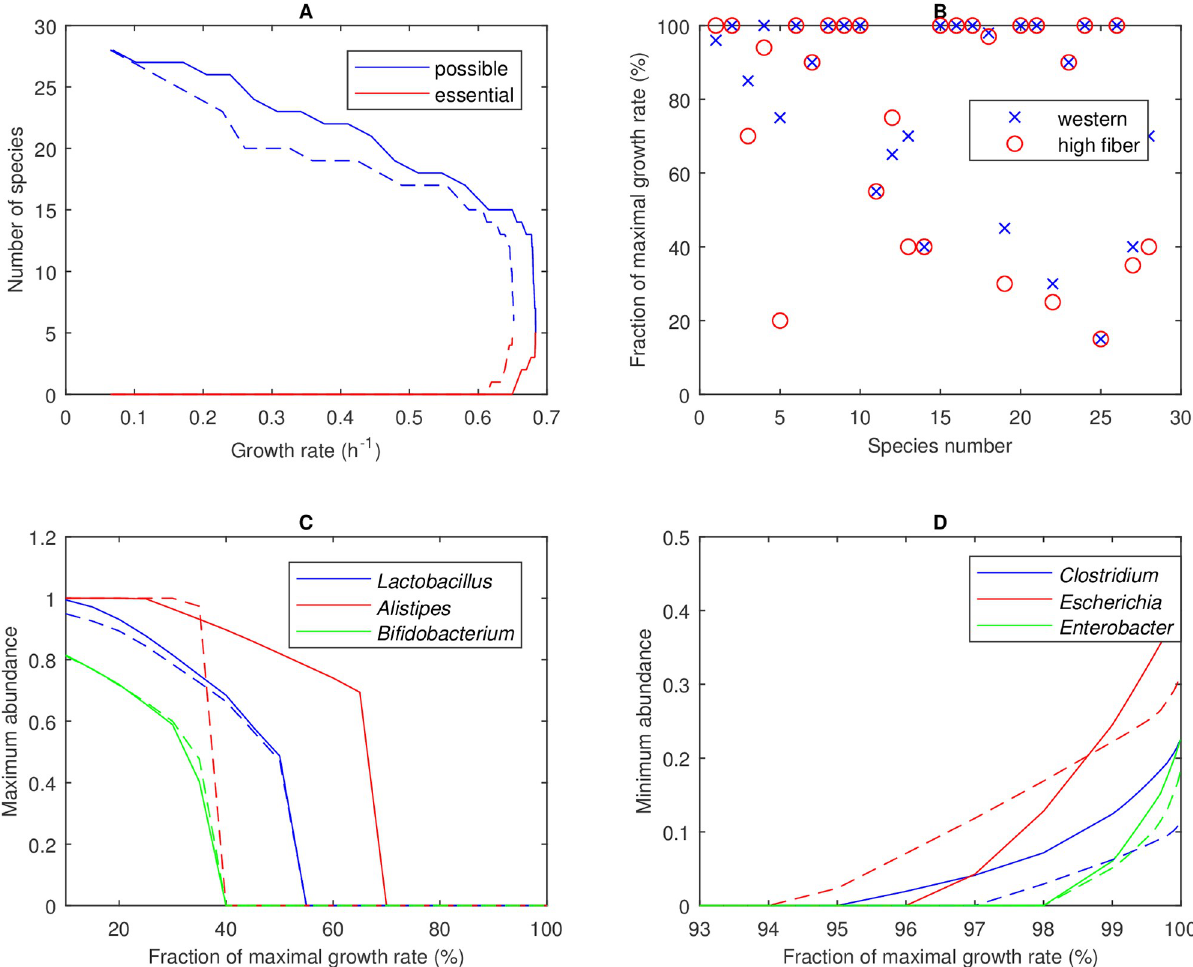
Fig 3. Community FVA performed for the 28-species community with Western (solid lines) and high-fiber (dashed lines) diets. (A) Number of possible species, defined as a species for which its abundance could be maximized to exceed 1%, and essential species, defined as a species for which its abundance could be minimized to be exceed 1%. (B) Community growth rate at which the abundance of each species could no longer exceed 1% when maximized with species numbers corresponding to Table 1. (C) Three representative species that could not coexist below 70% of the maximal growth rate. (D) Three representative species that had to be present in the community at high growth